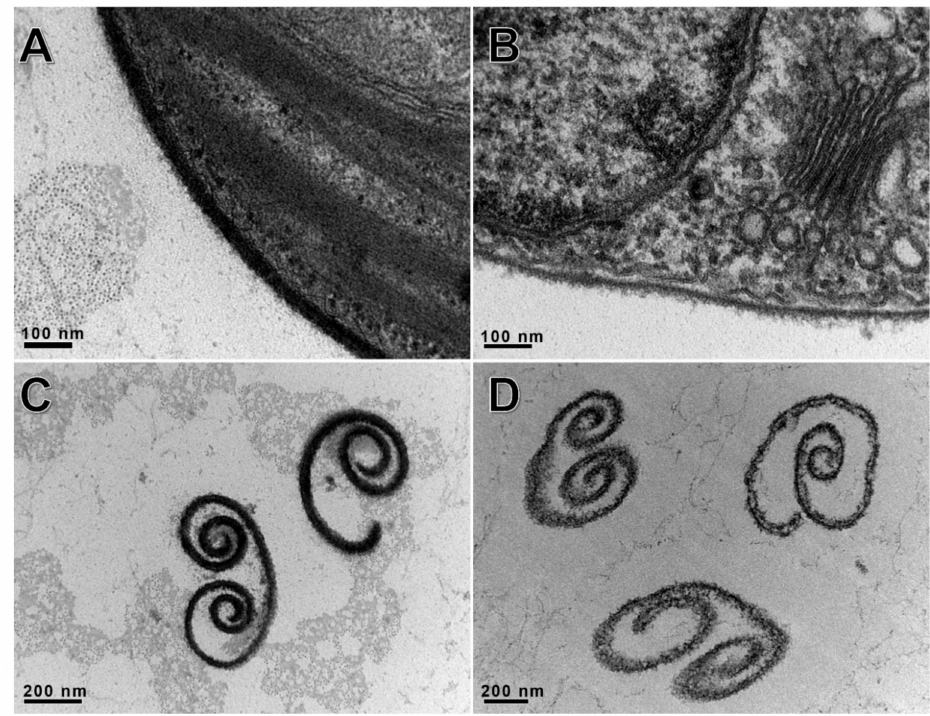
Figure 4. Degradation of C. variabilis NC64A cell walls after 10 min of digestion with 250 µ g/mL of A561L D4 visualized by TEM. ( A , C ) were treated with the recombinant protein, ( B , D ) were controls. Top panels ( A , B ) represent live cells and bottom panels ( C , D ) cell wall